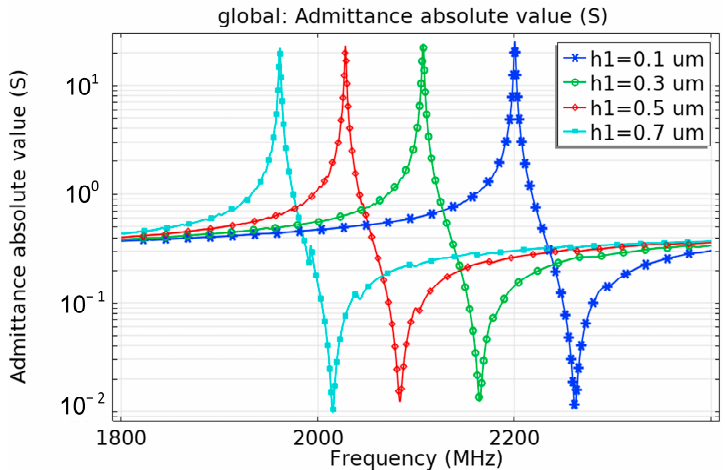
Figure 7. Influence of substrate thickness h on the admittance curve.